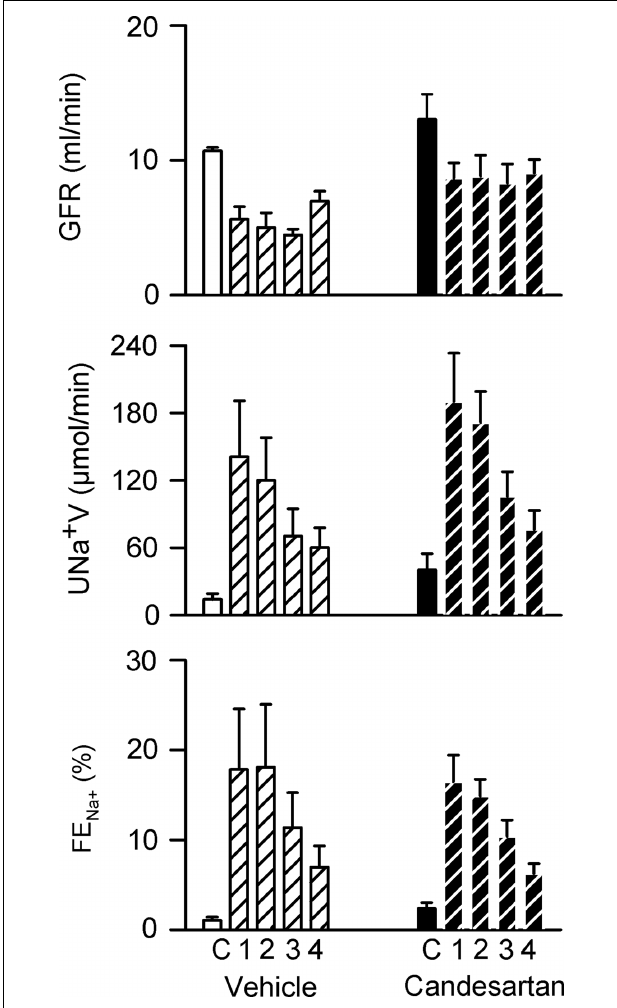
FIGURE 6 | Responses of renal excretory variables to plasma volume expansion in conscious rabbits treated with candesartan or its vehicle. GFR, glomerular filtration rate; U Na + V, sodium excretion; FE Na + , fractional sodium excretion. C = control, 1, 2, 3, and 4 refer to the consecutive 20min clearance periods after plasma volume expansion. P values for the outcomes of two-way repeated measures analysis of variance are shown in Table 2 .These indicate significant changes in GFR, U Na + V, and FE Na + in response to plasma volume expansion. However, there were no significant effects of candesartan on the responses of these variables to plasma volume expansion.